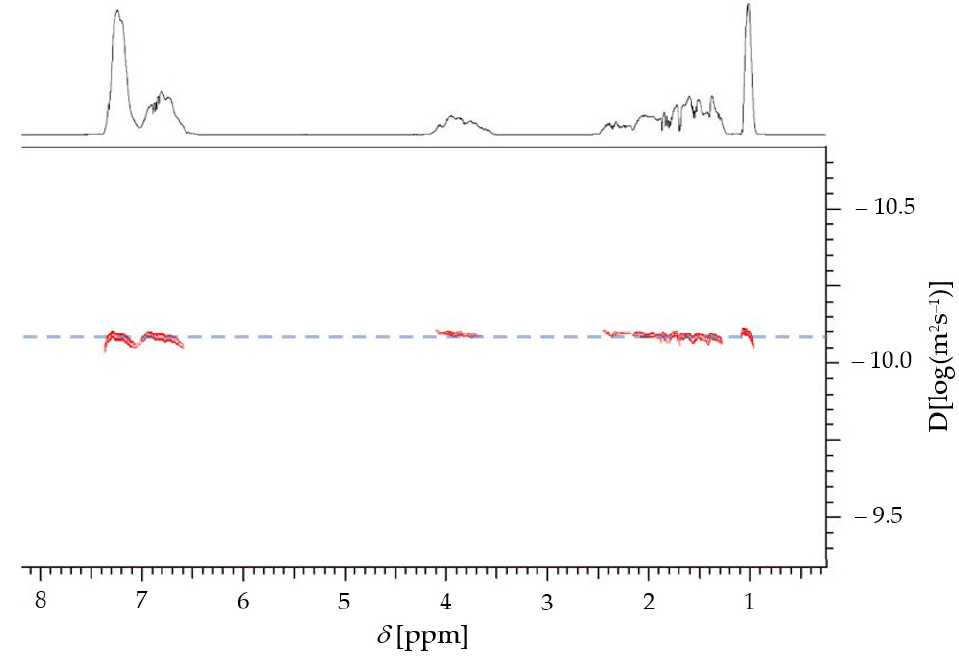
Figure 3. DOSY-NMR spectrum of PS- b -PBA- b -PS- b -PBA- b -PS ( P4c ) in CDCl 3 (500 MHz).